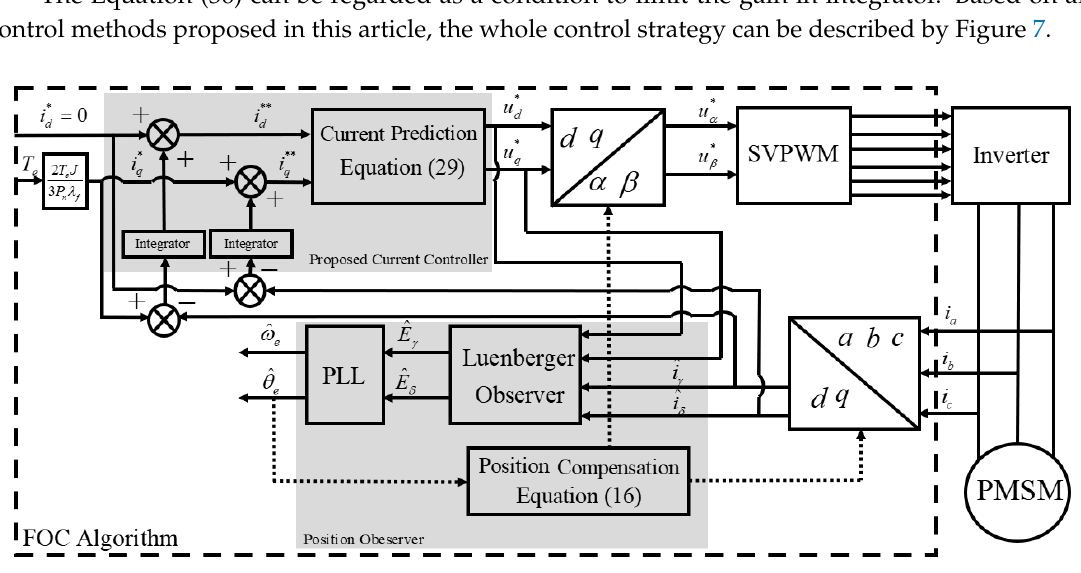
Figure 7. The whole proposed PMSM control method.